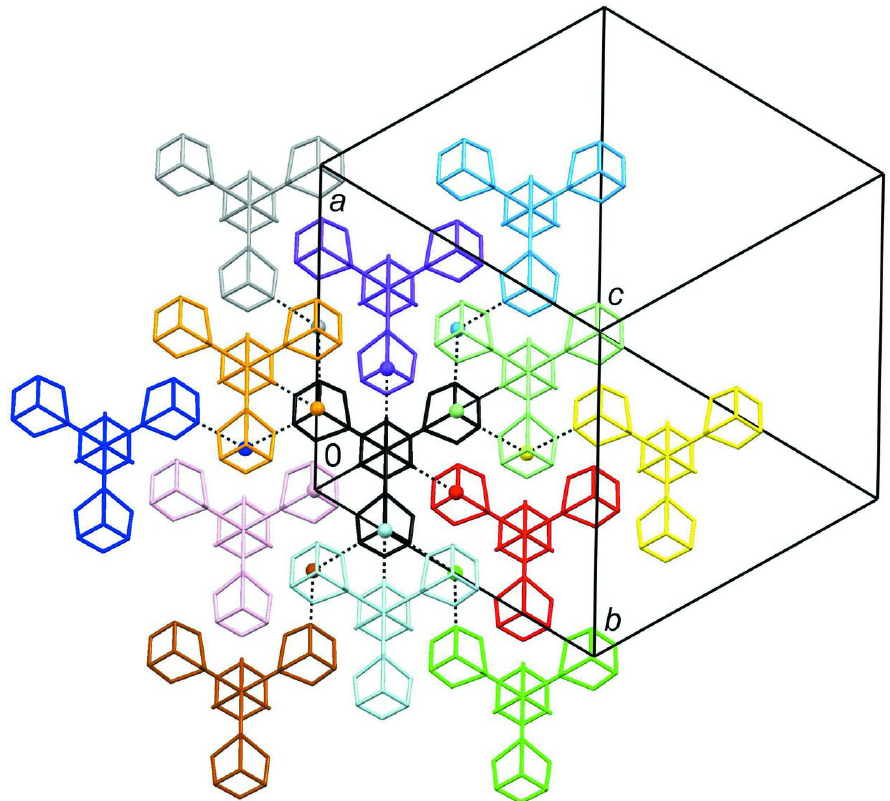
Figure 2 Fragment of the crystal packing diagram of (I) showing the simultaneous multidimensional interlinkage of the central monomeric [Cu(PTA)4]+ unit (black coloured) with twelve neighbouring ones (each represented by different colour) via repeating O10—H10···N1 hydrogen bonding interactions (black dashed lines) between crystallization water molecules O10 (coloured balls) and PTA N1 atoms. H and Cl atoms are omitted for